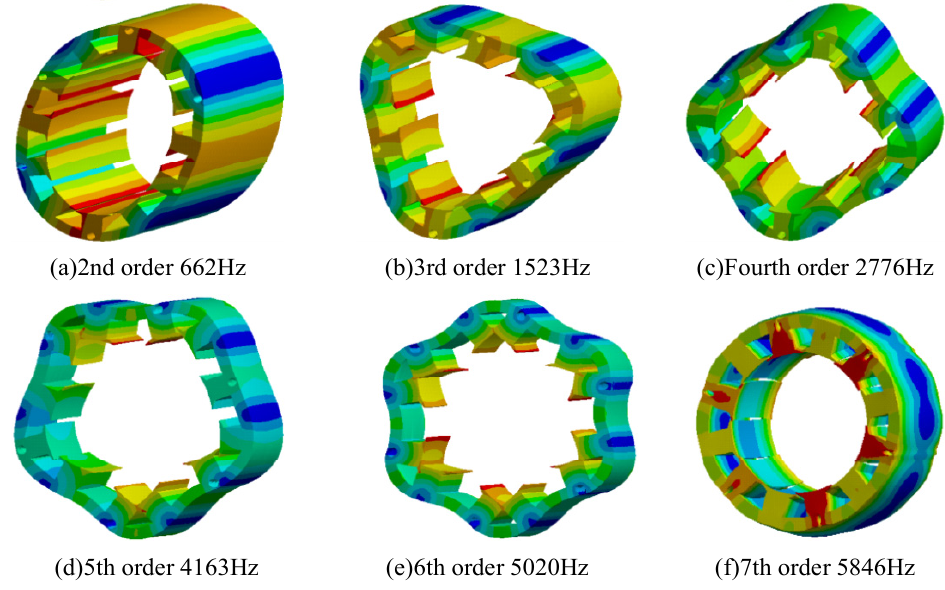
Figure 5. Modal shape of FeCo-based stator. Table 9. Frequency distribution of low-order radial force harmonics of 8-pole, 12-slot, permanent- magnet